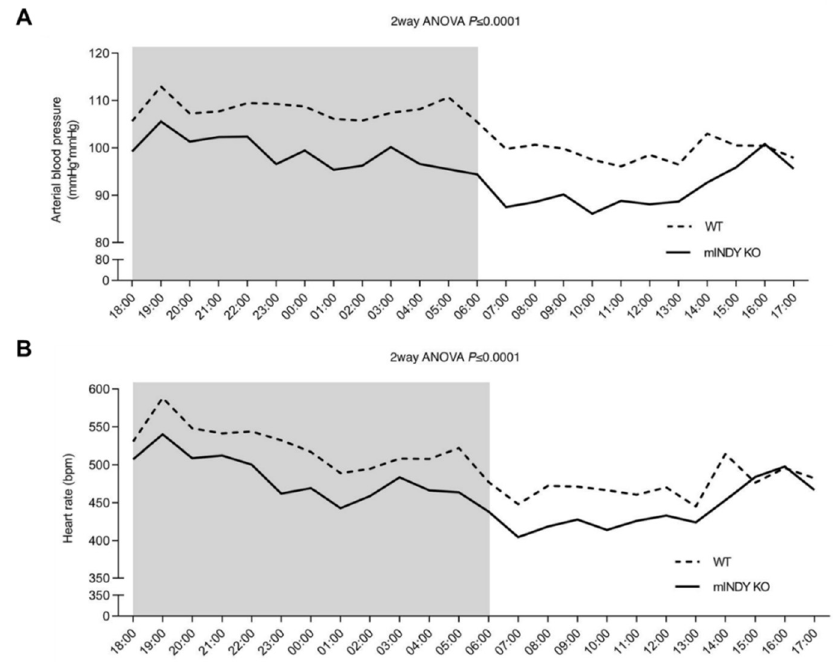
Figure 2. Arterial blood pressure ( A ) and heart rate ( B ) in mIndy -KO mice (n = 6) and WT littermate controls (n = 8) on a regular chow diet. Arterial blood pressure ( A ) monitored by a radiotelemetry system was on average 8 mmHg lower in mIndy knockout mice compared to WT controls. Heart rate ( B ) was on average 37 bpm lower in mIndy knockout mice compared with WT controls. KO-knock-out; WT-wild-type; bpm-beats per minute; see [42] for more details.